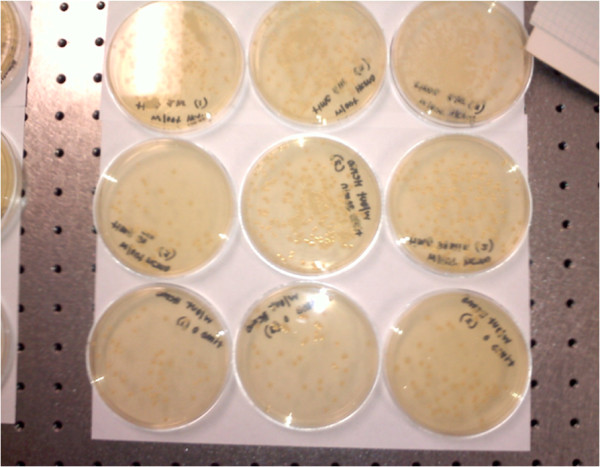
Laser-induced bactericidal effect of haemozoin.Escherichia coli colonies on agar plates following 0 (upper row), 20 (middle row) and 40 (lower row) minutes of irradiation in the presence of 1 μM synthetic haemozoin.